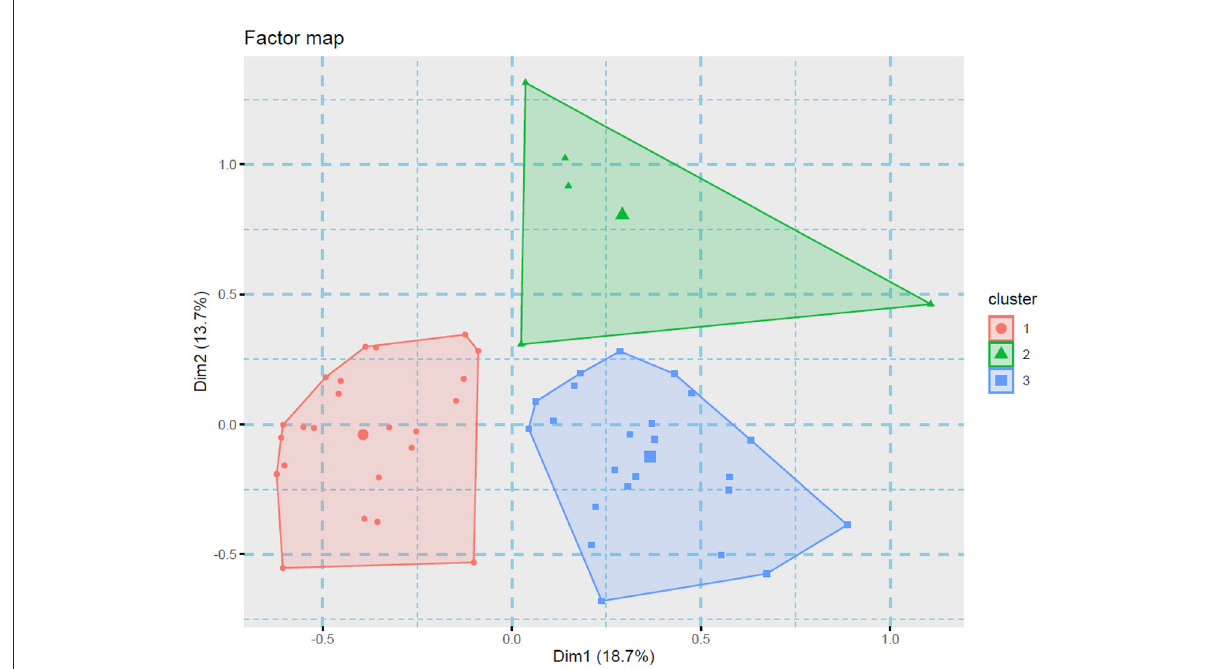
FIGURE1 Cluster analysis of the variables associated with the mental health outcomes. The variables showed a distribution in three groups (designated in an ad hoc way in this